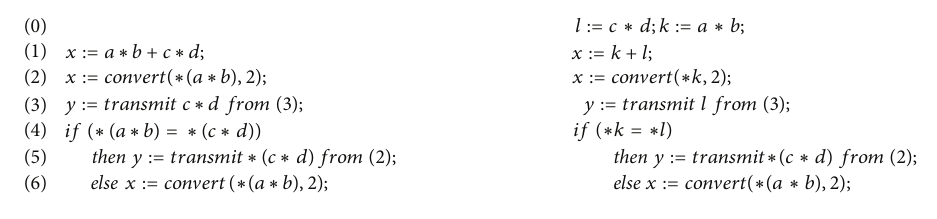
Figure 1: Motivating